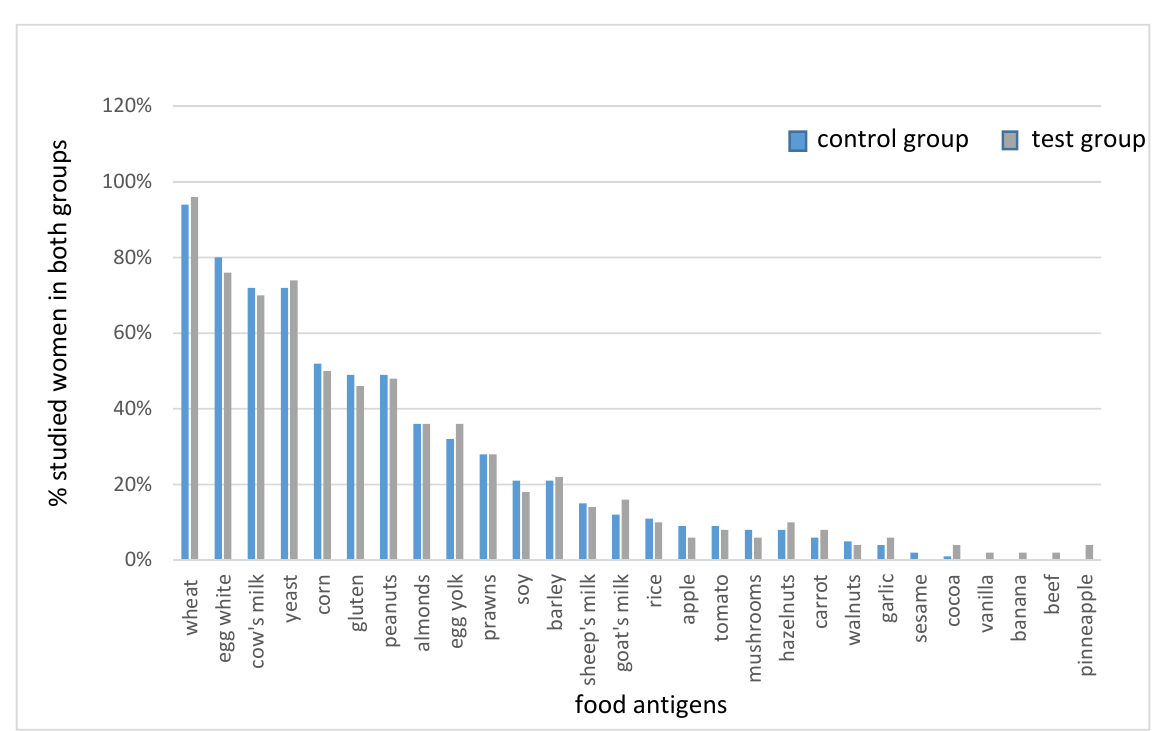
Figure 1. IgG 1-3 food sensitivity in both studied groups.